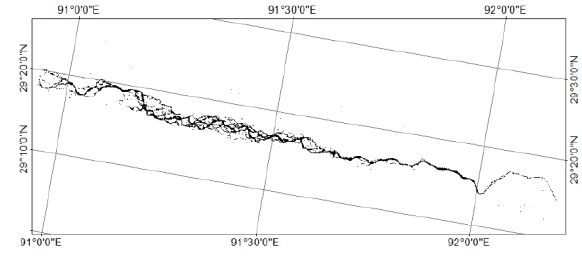
Figure 7. River extraction result using OC